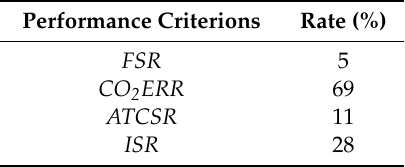
Table 10. Results of the annual performance evaluation of the hybrid PV / Stirling / battery